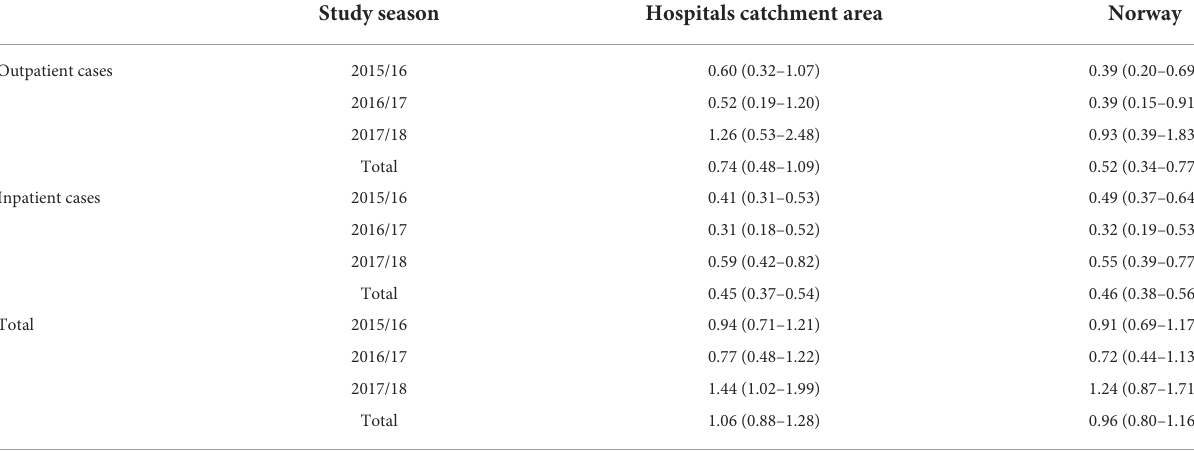
TABLE 2 Estimated influenza incidence per 1,000 in children 0–18 years of age.